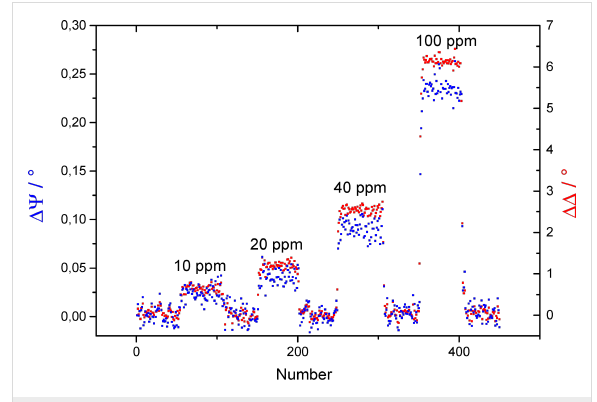
Figure 5: Comparison of the change in Ψ and Δ at an AOI of 44.5° after exposure for different concentrations of CO on a Fe:SnO x coating. The standard deviations σ for ΔΨ and ΔΔ are 0.04° and 0.016°, respectively.